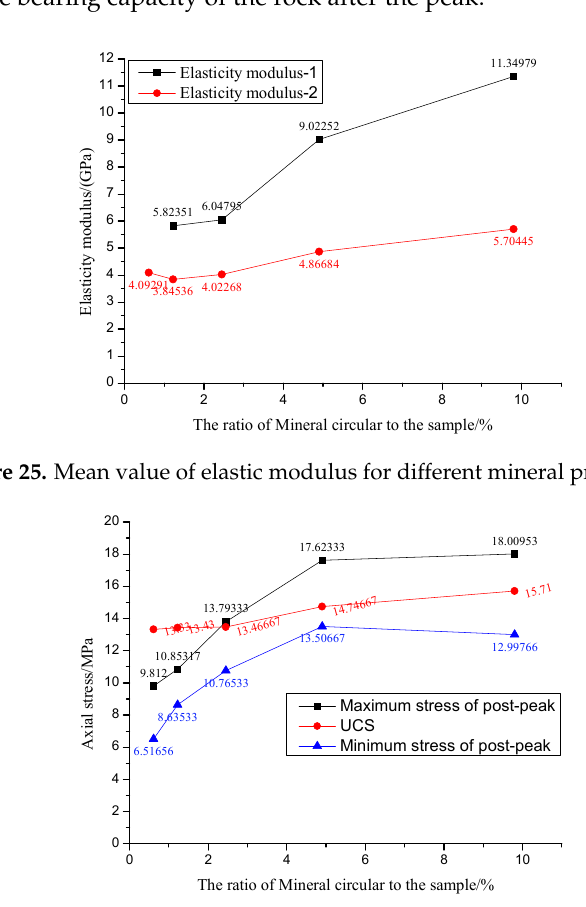
Figure 26. UCS and maximum and minimum stress post-peak for different mineral ratios.